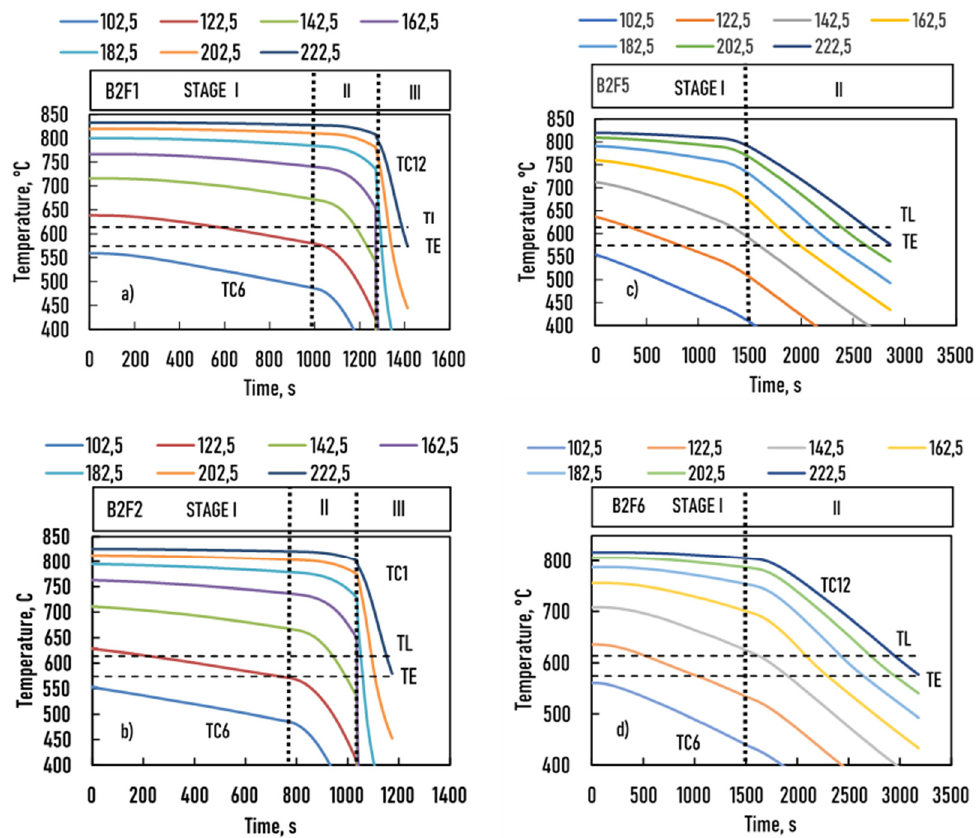
Figure 2. Temperature recordings as a function of time for the four samples. ( a ) B2F1, ( b ) B2F2, ( c ) B2F5, and ( d ) B2F6.